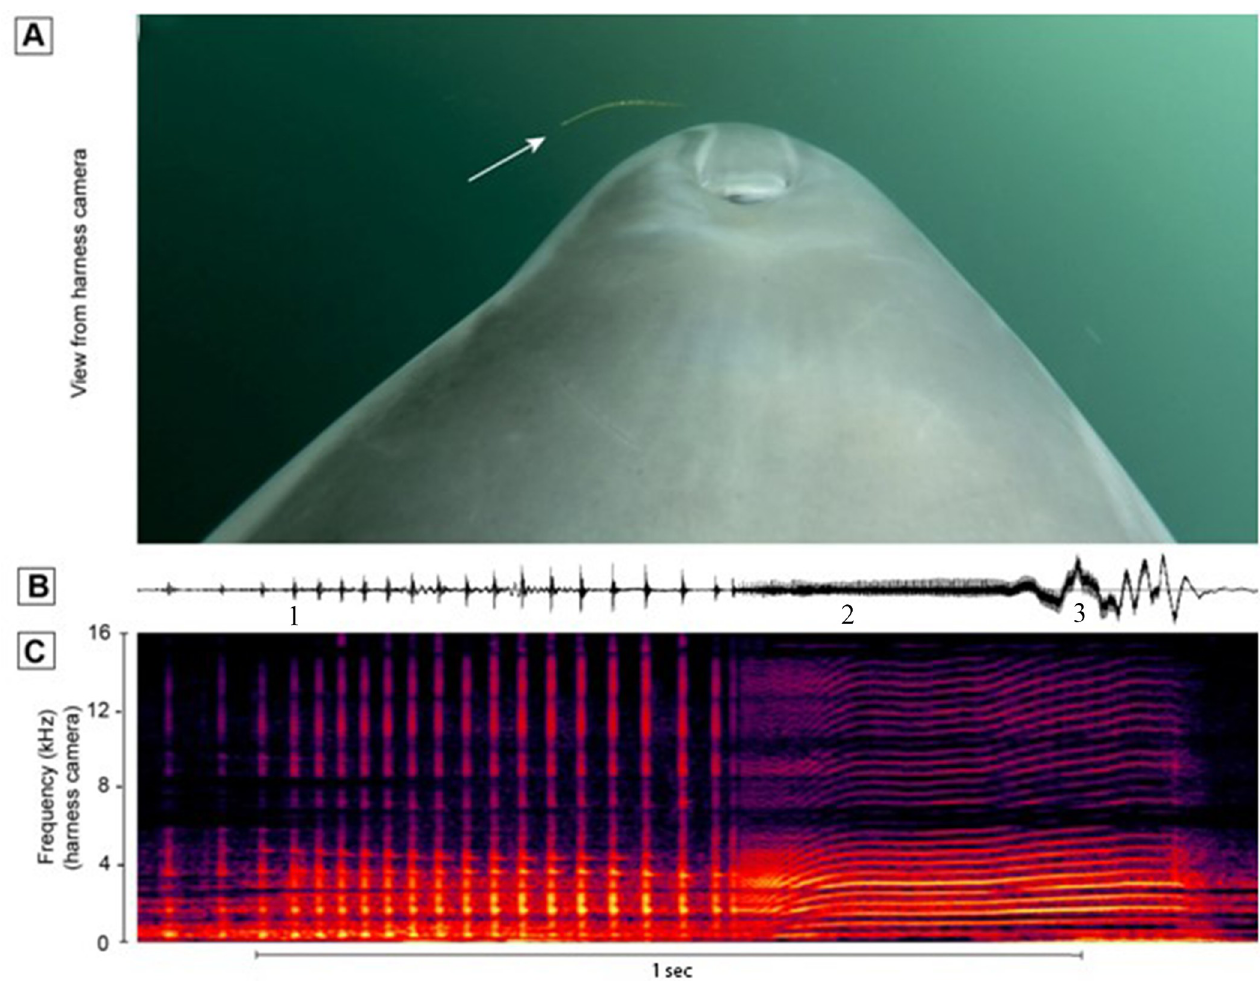
Fig 6. A . View of dolphin fore body while nearing sea snake B. Amplitude of sound recorded as dolphin Z located and captured a sea snake. Head jerks (abrupt amplitude changes at the end of B ) are indicative of swallowing prey [9]. C . Spectrogram of audible sound.